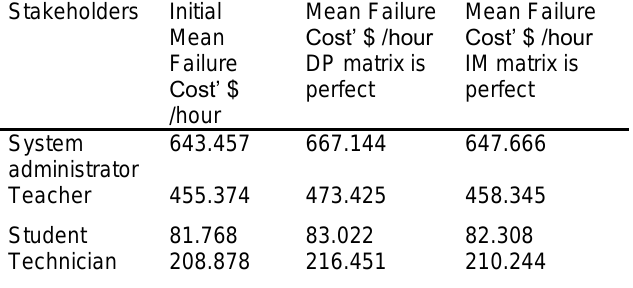
Table 3: Security problems diagnostic of the MFC for e-learning systems case